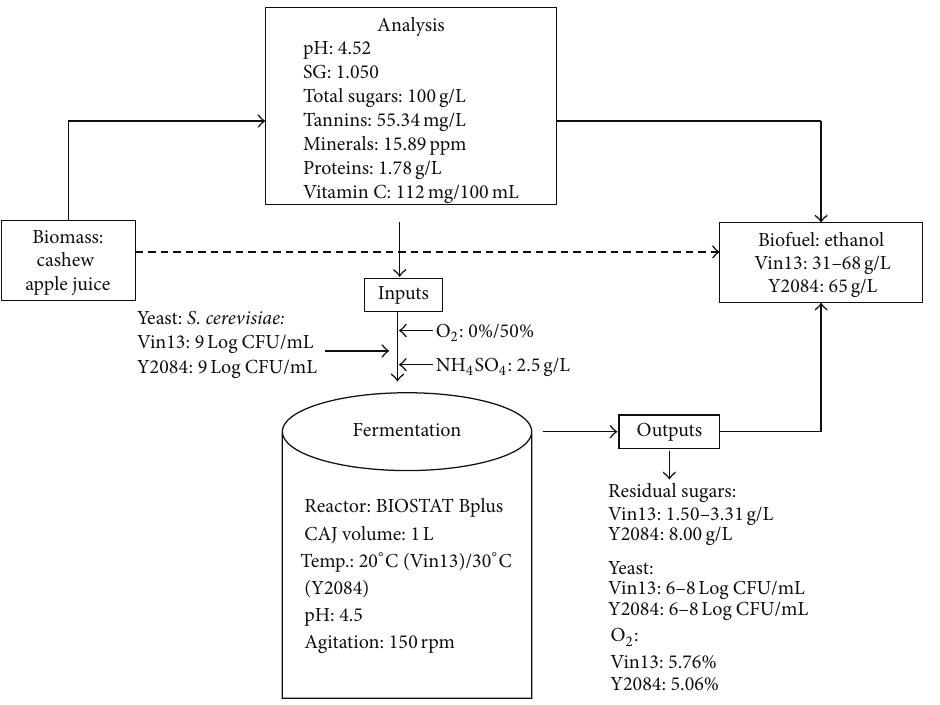
Figure 3: Cashew apple juice-ethanol production